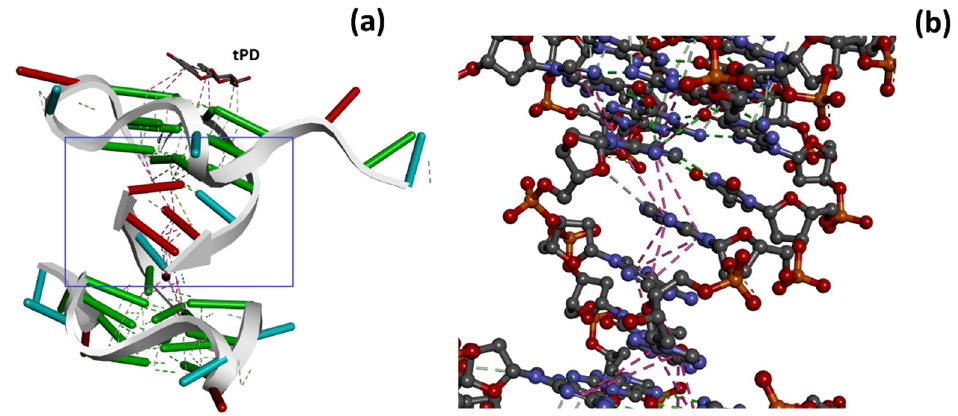
Figure 5. ( a ) Detailed pose view of the trimeric complex (tPD-Pu22)-Pu22 of Figure 4b; tPD structure is indicated. ( b ) Enlargement of the area delimited by the blue rectangle.